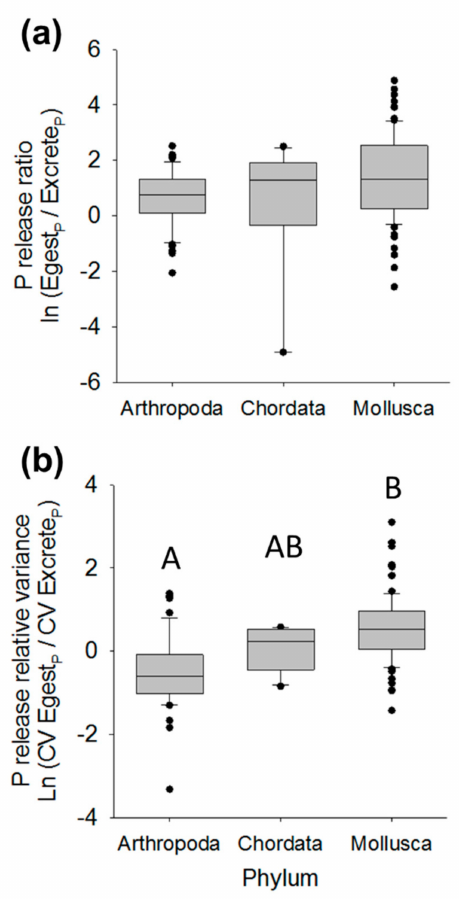
Figure 2. Box and whisker plots of P release ratios ( a ) or P relative release variance ( b ) based on total P egestion relative to inorganic P excretion across distinct phyla. In both ( a ) and ( b ), weighted mixed e ff ects models including both phylum and body size provided the best-fit explanation of release ratios or relative variance (Tables 2 and 3). Upper-case letters A and B in panel ( b ) indicate significant di ff erences across phyla based on Tukey’s honestly significant di ff erence (HSD) ( p < 0.05), with Arthropoda exhibiting significantly lower P release relative variance compared to Mollusca, and Chordata statistically similar to both groups. There are no upper-case letters in panel ( a ) because Phyla did not significantly di ff er in P release